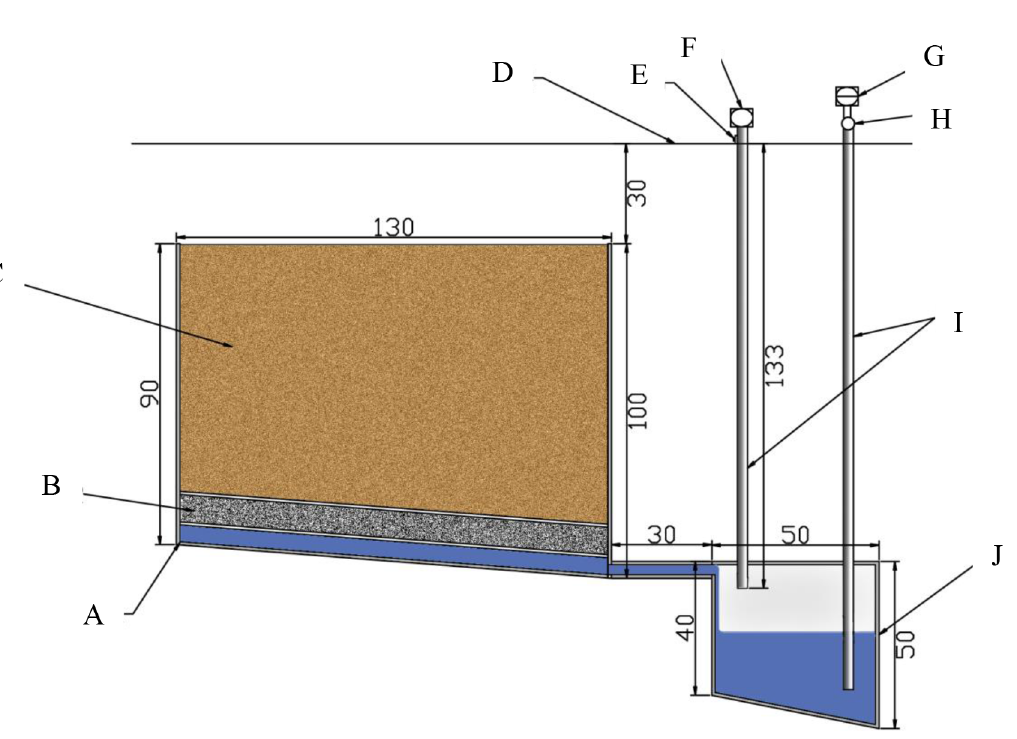
Fig 1. Sketch of the lysimeters. A, box. B, filter layer. C, test Soils. D, soil surface. E, snorkel off valve. F, pressure pump. G, aspirator. H, graduate. I, plastic pipe. J,